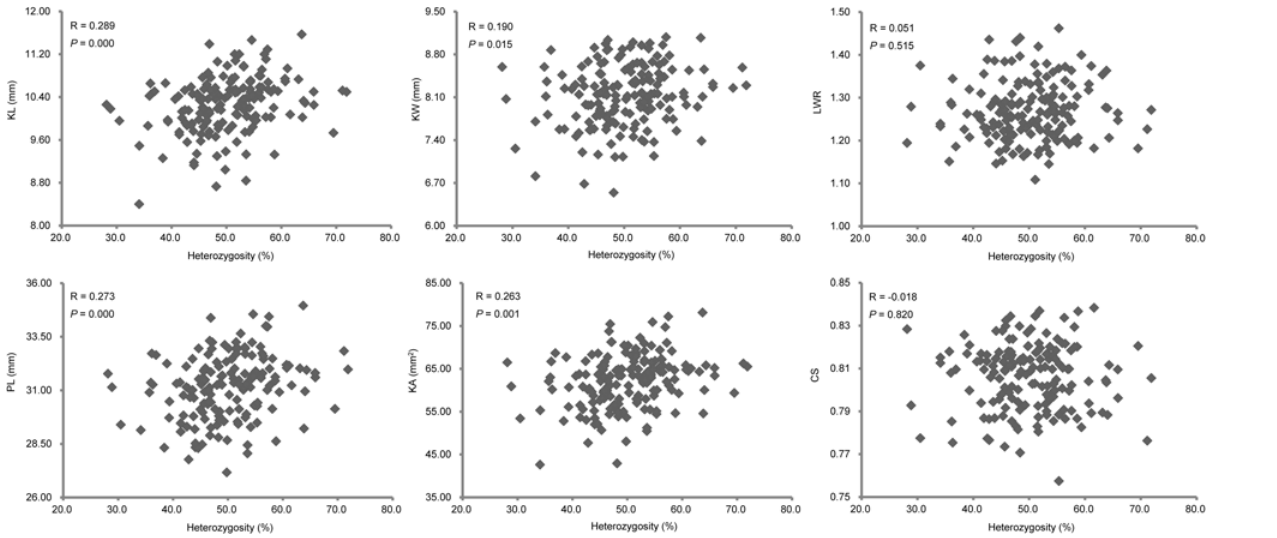
Fig 4. The relationship between heterozygosity and KSRTs based on TC(B) and TC(M) populations.